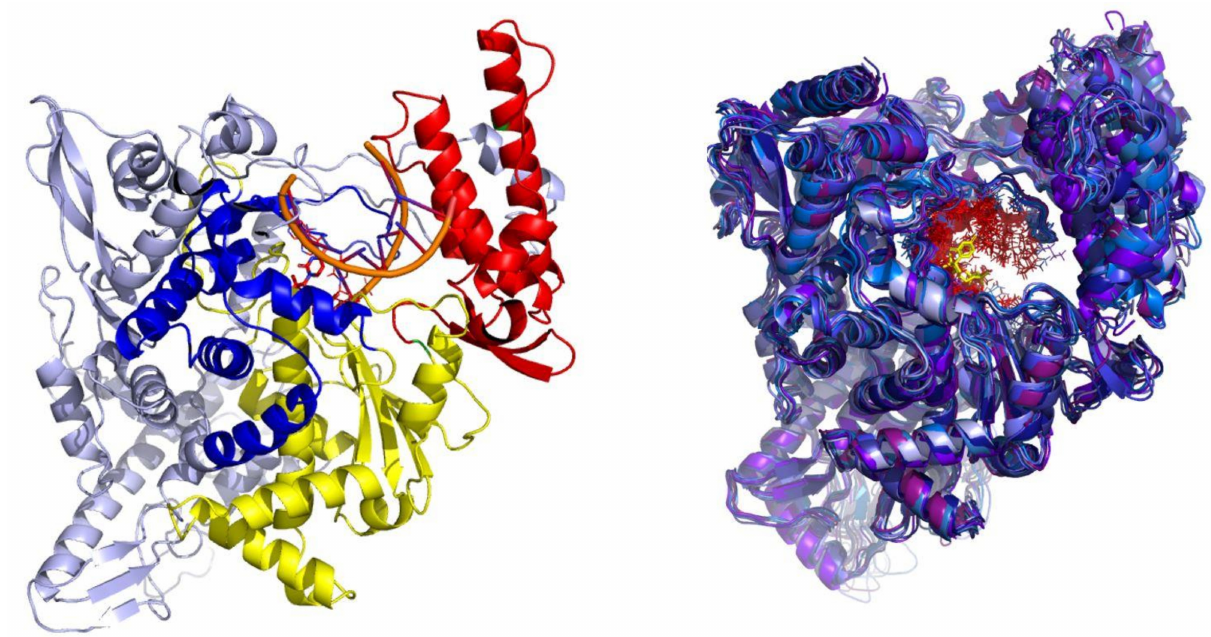
Figure 5. ( Left ) SARS-CoV-2 RdRp identified subdomains. Protein is presented in a cartoon model with the thumb subdomain in red, the palm subdomain in yellow and the fingers subdomain in blue. The RNA channel groove can be found in the central cavity between all three described subdomains (RNA in orange is superimposed from PDB ID: 4WTG for demonstration). ( Right ) Structural superimposition of the clustered centroids representing the conformational flexibility of the SARS-CoV-2 RdRp during the MD experiment. Centrally colored in red is the identified binding site with superimposed sofosbuvir from PDB ID: 4WTG in